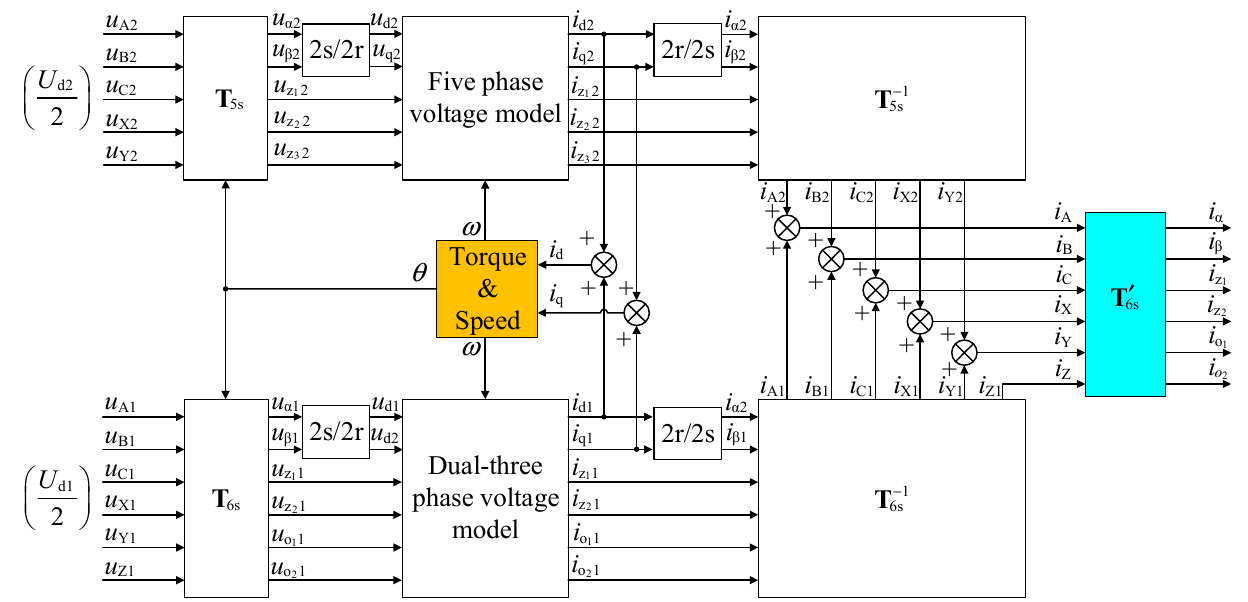
Figure 2. The block diagram of the superposition control model of the post-fault dual three-phase PMSM. To control the post-fault motor through the stator currents obtained in Figure 2,